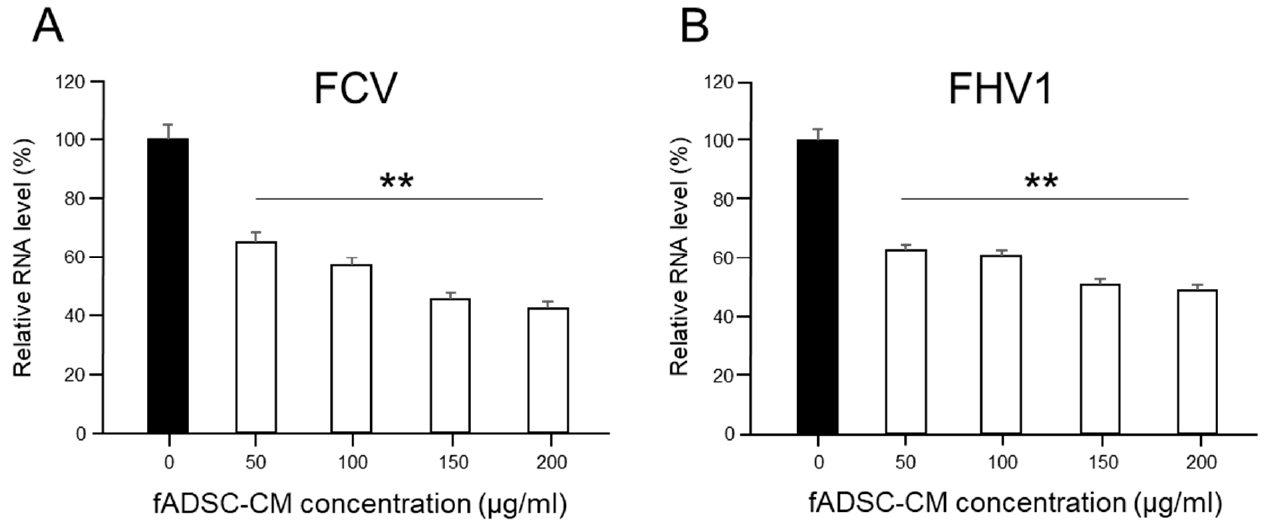
Figure 4. Dose-dependent effects of fADSC-CM on viral replication ( A ) Relative FCV viral mRNA levels in CRFK cells. ( B ) Relative FHV1 viral mRNA levels in CRFK cells. Data are expressed as the mean ± standard deviation. Asterisks indicate significant differences compared with mock-treated group (**, p < 0.01).